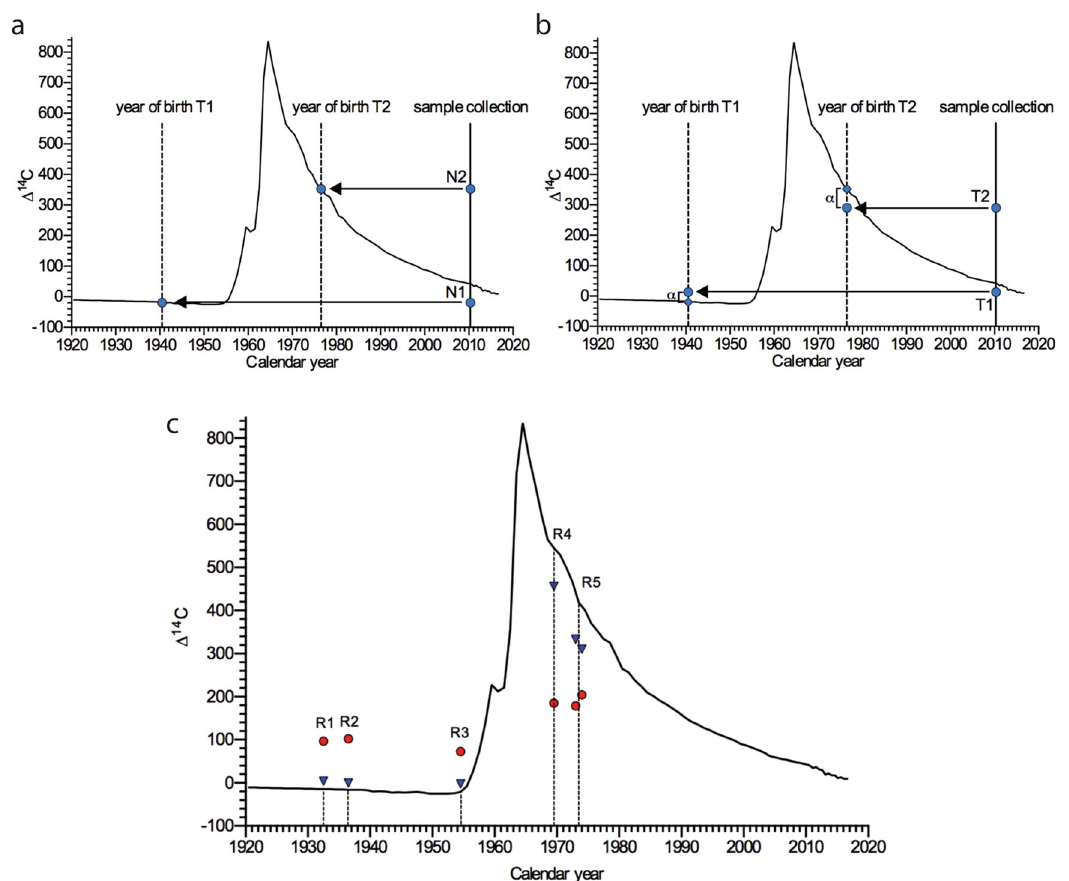
a , b Interpretation of two hypothetical scenarios of differential cell turnover utilizing radiocarbon-based retrospective birth dating of cells. Atmospheric 14 C concentrations of the last century are depicted by the black line. The vertical solid line represents the year of hypothetical sample collection. a In a no- cell-turnover-scenario the concentrations of genomic 14 C in the year of sample collection of two individuals (N1, born 1940 and N2, born 1976) are identical to the atmospheric 14 C levels in the years of birth of the individuals. The vertical dashed line represents the year of birth of the individuals and in this scenario meets the atmospheric 14 C curve at the exact 14 C concentration found at sample collection. b In a cell-turnover scenario the concentrations of genomic 14 C levels in the year of sample collection of two individuals (T1, born 1940 and T2, born 1976) differ (alpha) from the atmospheric 14 C levels in the years of birth of the individuals (vertical dashed line). In this turnover scenario the 14 C levels of individuals born before the 14 C peak are higher than the atmospheric 14 C curve in the year of birth, whereas the 14 C levels of individuals born after the 14 C peak are below the atmospheric 14 C curve in the year of birth of individuals. c 14 C concentrations determined by accelerator mass spectrometry of twelve DNA samples derived from the amygdalae of fi ve different, neurologically healthy subjects (R1-R5; bilateral amygdala of patient R5). Individual values are plotted at the time of birth of the respective subject (vertical dashed line). 14 C levels of non-neuronal cells (red) and neuronal cells (blue) differ from the atmospheric 14 C levels at the time of birth of the individuals, indicating post-natal